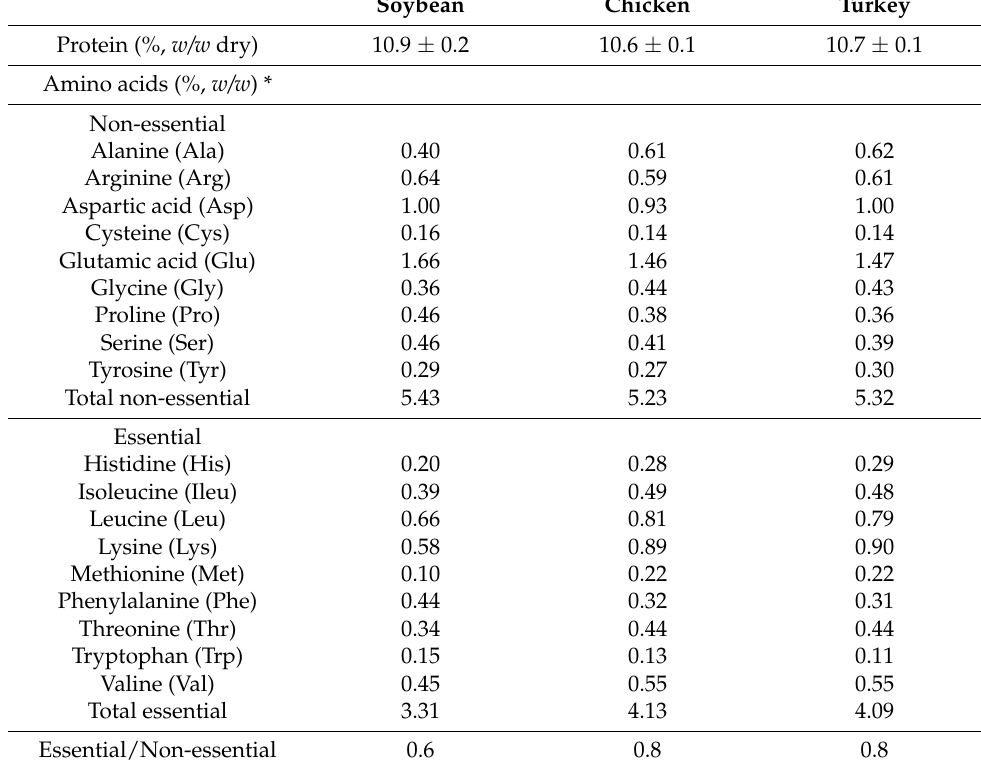
Table 2. Total protein and amino acid composition of the experimental diets.